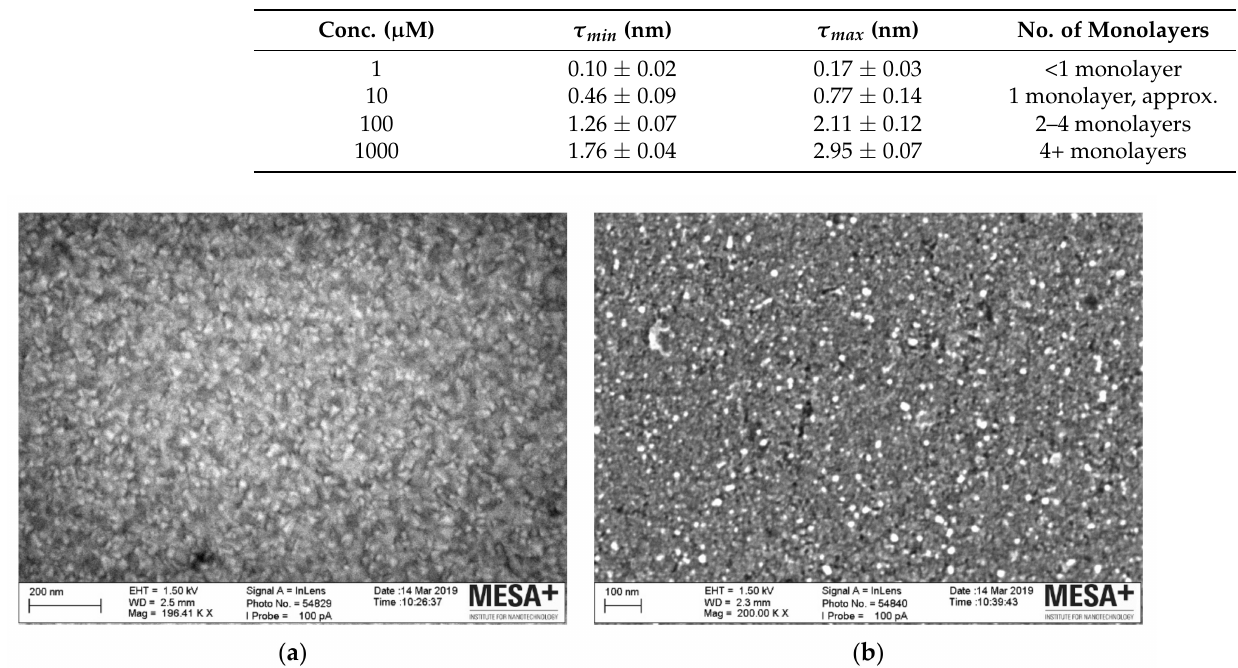
Table 1. Estimated minimum (dehydrated) and maximum (fully hydrated) τ after 10 min CA at different concentrations of Na 2 Cr 2 O 7 .